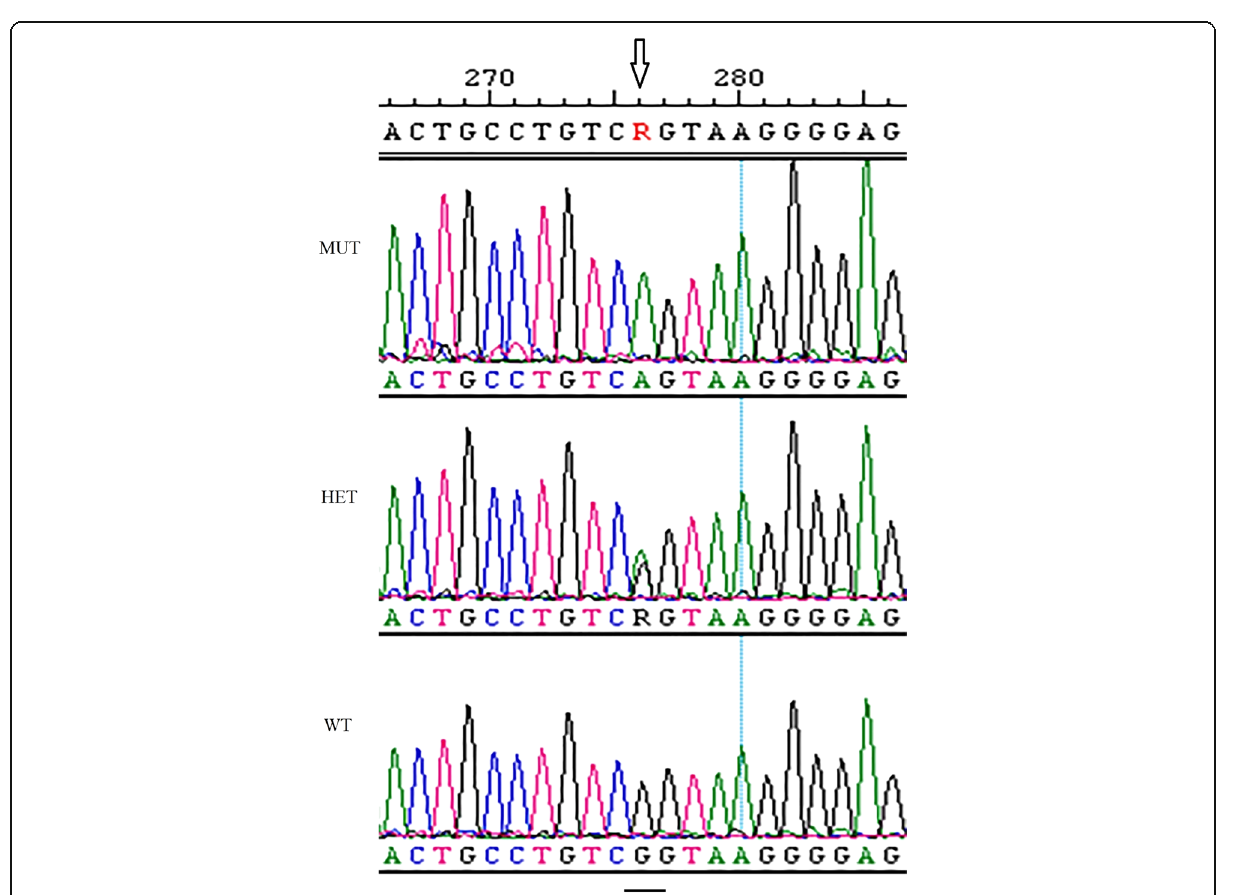
Fig. 2 Von Willebrand ’ s Factor mutation analysis. Example of chromosomal DNA containing Von Willebrand ’ s Factor c.7437G > A. WT = wildtype, HET = heterozygous carrier, MUT = homozygous